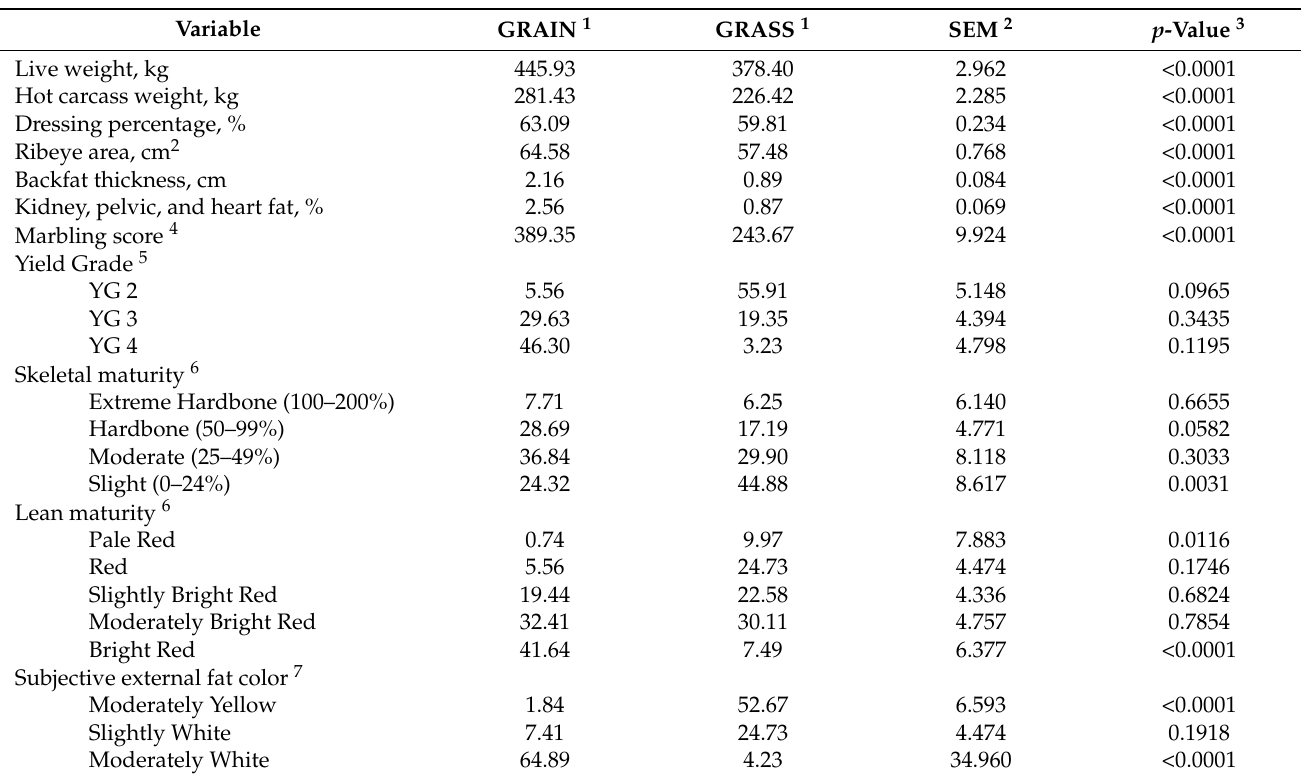
Table 1. Least squares means for effect of finishing system on live weight and carcass characteristics of grain- or grass- finished bison